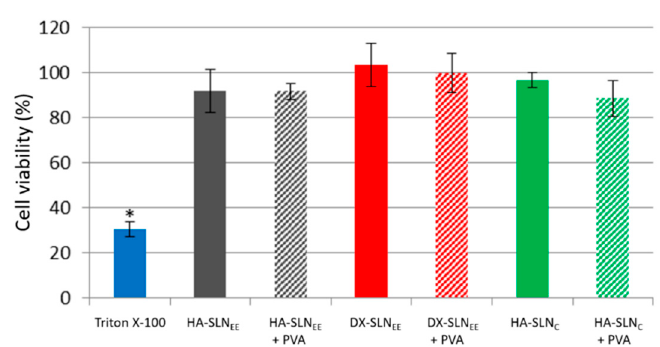
Figure 3. Cell viability after treatment of HCE-2 cells with Triton X-100 as positive control, and with the following formulations: HA-SLN C , HA-SLN C with PVA, DX-SLN EE , DX-SLN EE with PVA, HA-SLN EE , and HA-SLN EE with PVA. The percentage of viable cells was expressed as percentage respect to untreated cells. * p < 0.01 respect to the formulations. HA: hyaluronic acid; PVA: polyvinyl alcohol; DX: dextran; SLN: solid lipid nanoparticle; HCE-2 cells: human corneal epithelial cells. n = 3; data are expressed as mean ± standard deviation.